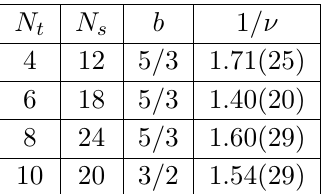
Table 2 . The critical exponent 1 =(cid:23) with the topological action from N t = 4 ; 6 ; 8 ; 10 lattices.